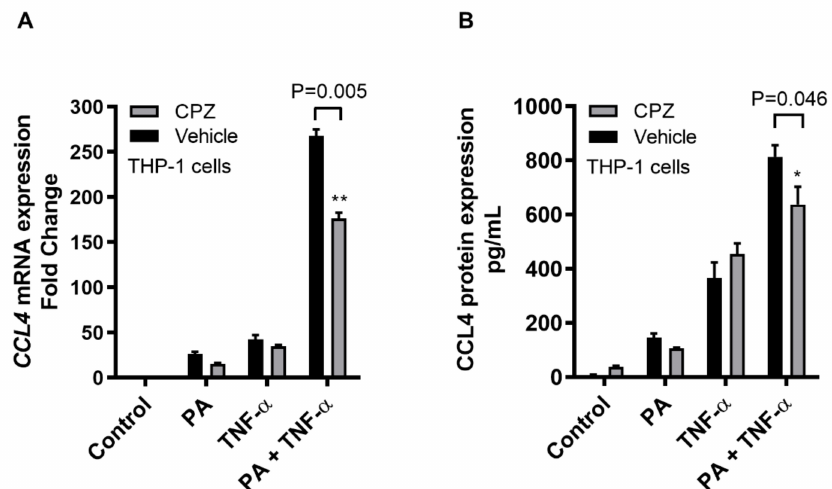
Figure 3. CCL4 co-induced by TNF- α / palmitate involves the clathrin-mediated endocytosis. To see if the CCL4 co-induction by TNF- α / palmitate involved the clathrin-mediated endocytosis, THP-1 monocytic cells were treated with specific inhibitor chlorpromazine (CPZ) before co-stimulation with TNF- α / palmitate as described in the materials and methods section. The data (mean ± SEM) show that CPZ-treated cells displayed significantly reduced expression of ( A ) CCL4 mRNA ( p = 0.005) and ( B ) secreted CCL4 protein ( p = 0.046) compared to the control (mock treatment). * Significant ( p < 0.05), ** Very significant ( p <